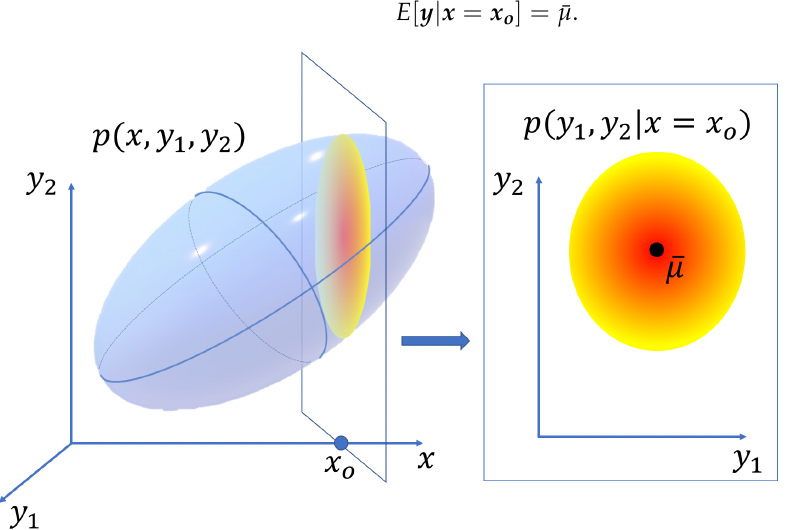
Figure 5. The conditional probability density function for a multivariate normal distribution is a lower dimensional multivariate normal